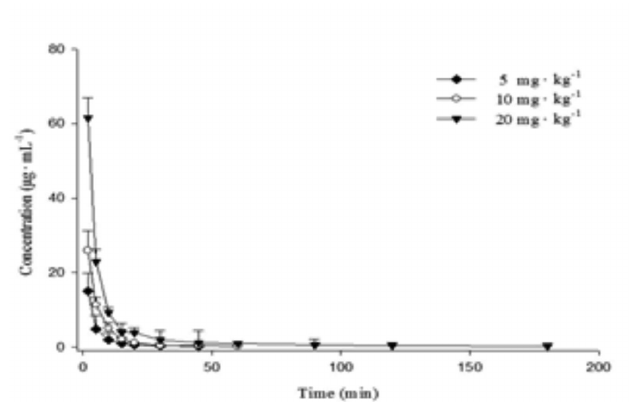
FIGURE 3 - Mean plasma concentration-time curves of isoquercitrin in rats (mean ± S.D., n = 5) after the intravenous administration of doses of 5, 10 and 20 mg ·kg -1 . These sampling points, which could not be detected, i.e. plasma concentrations under the LOQ, were not included in the mean plasma concentration-time